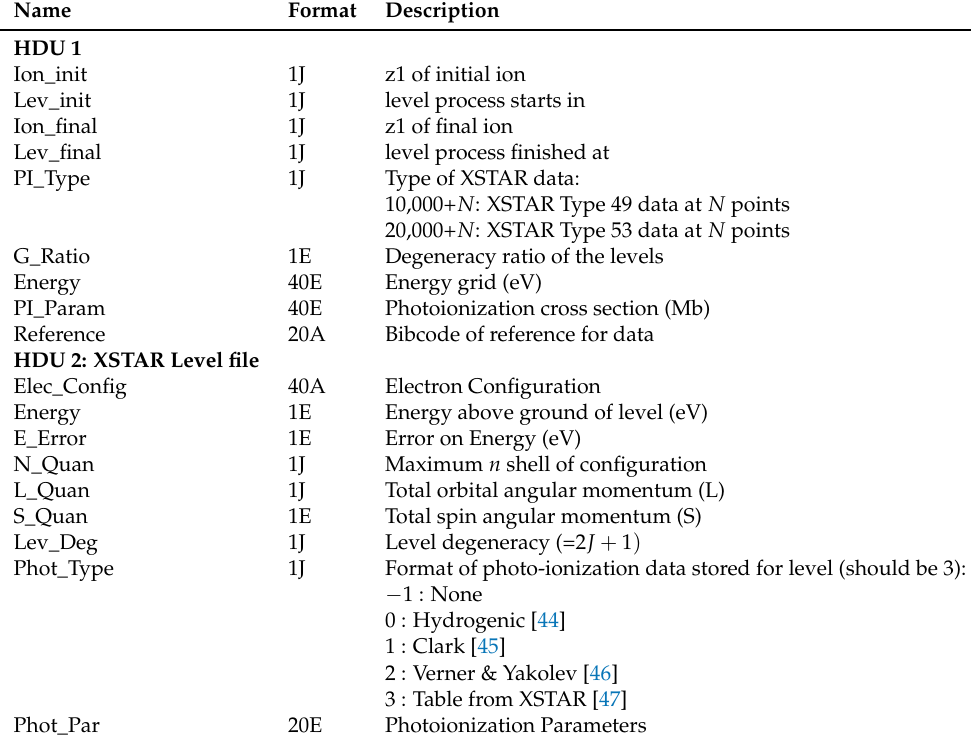
Table A7. APED PI (photoionization) file definition. This is used to store tabulated XSTAR style data.